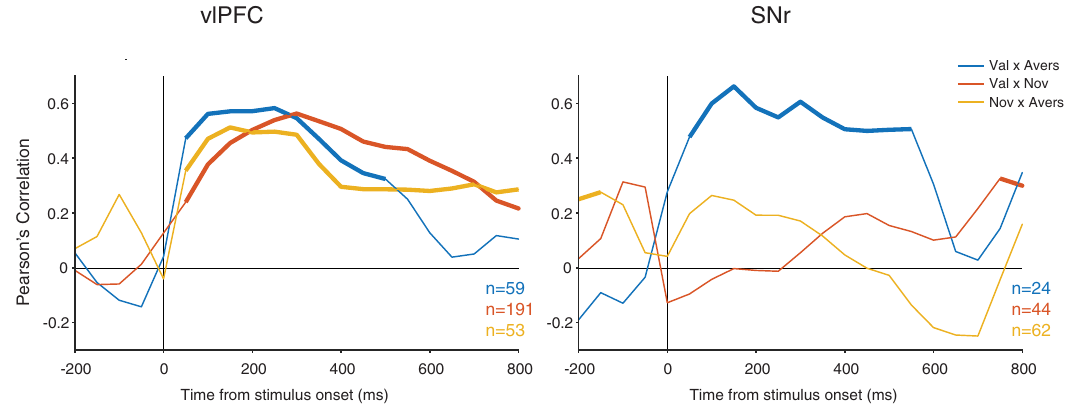
Fig. 6 | Sliding pairwise correlation between value, novelty and aversive (air- puff)signals in vlPFC and cdlSNr. Pairwise sliding correlation in300ms windows betweenvaluesignal(goodminusbad),novelty(novelminusfamiliar)andaversive signal (airpuff minus neutral) across neurons in vlPFC and cdlSNr across both monkeys. Think lines show signi fi cant correlations ( p <0.05). The pairwise